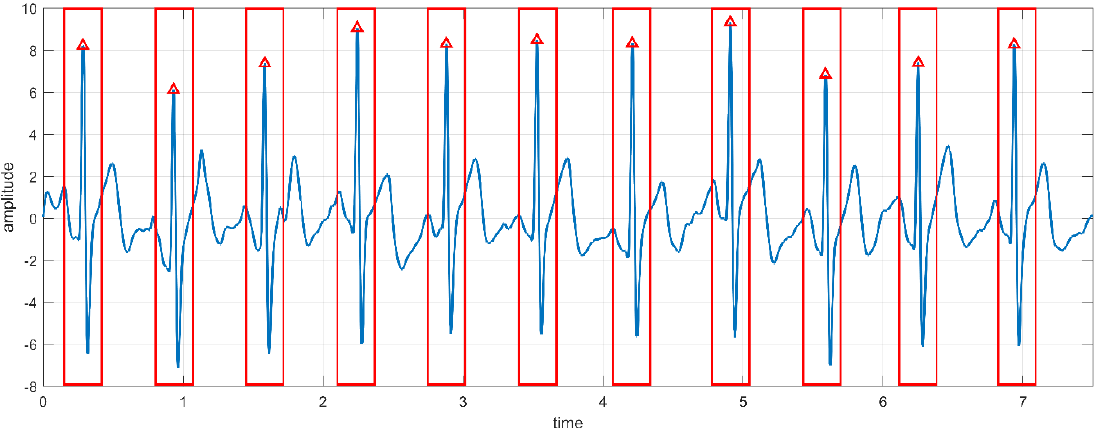
Figure 2. A fragment of ECG signal composed 11 beats, with the generated windows around R− peaks enclosed by red rectangles.